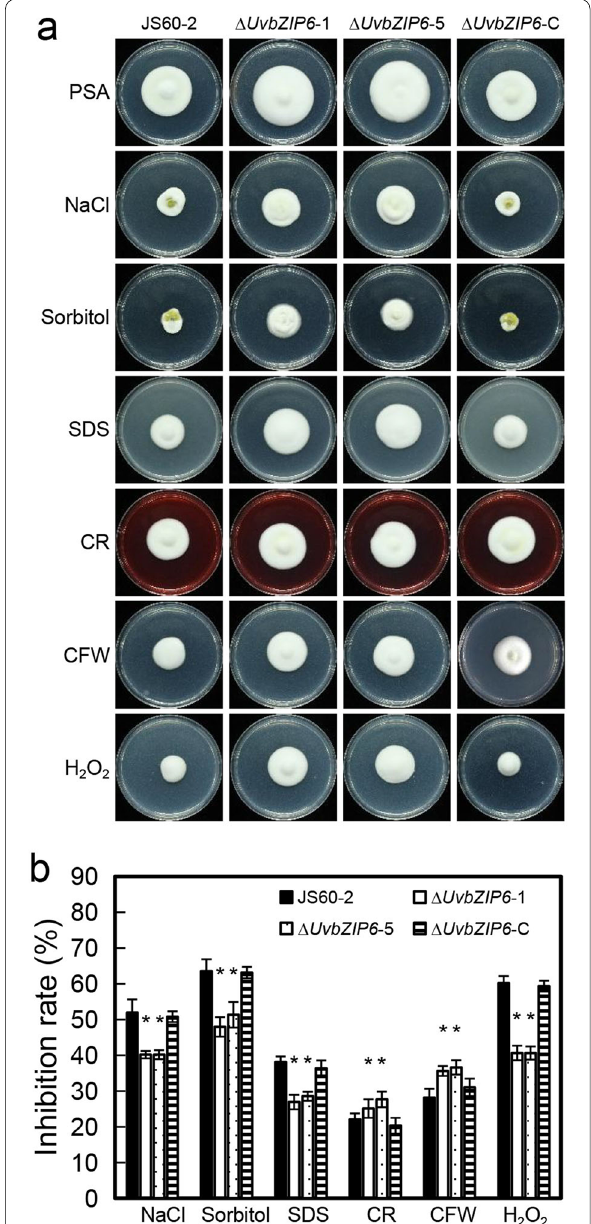
Fig. 5 UvbZIP6 regulates stress responses of U. virens . a Colony morphology of U. virens strains on media with different stress agents. The strains were cultured on PSA plates with 0.5 M NaCl, 0.9 M (CR), 120 μg/mL calcofluor white (CFW), or 0.03% H 2 O 2 for 14 days. b Inhibition rates of different stress agents on vegetative growth of the tested U. virens strains. The asterisks represent a significant